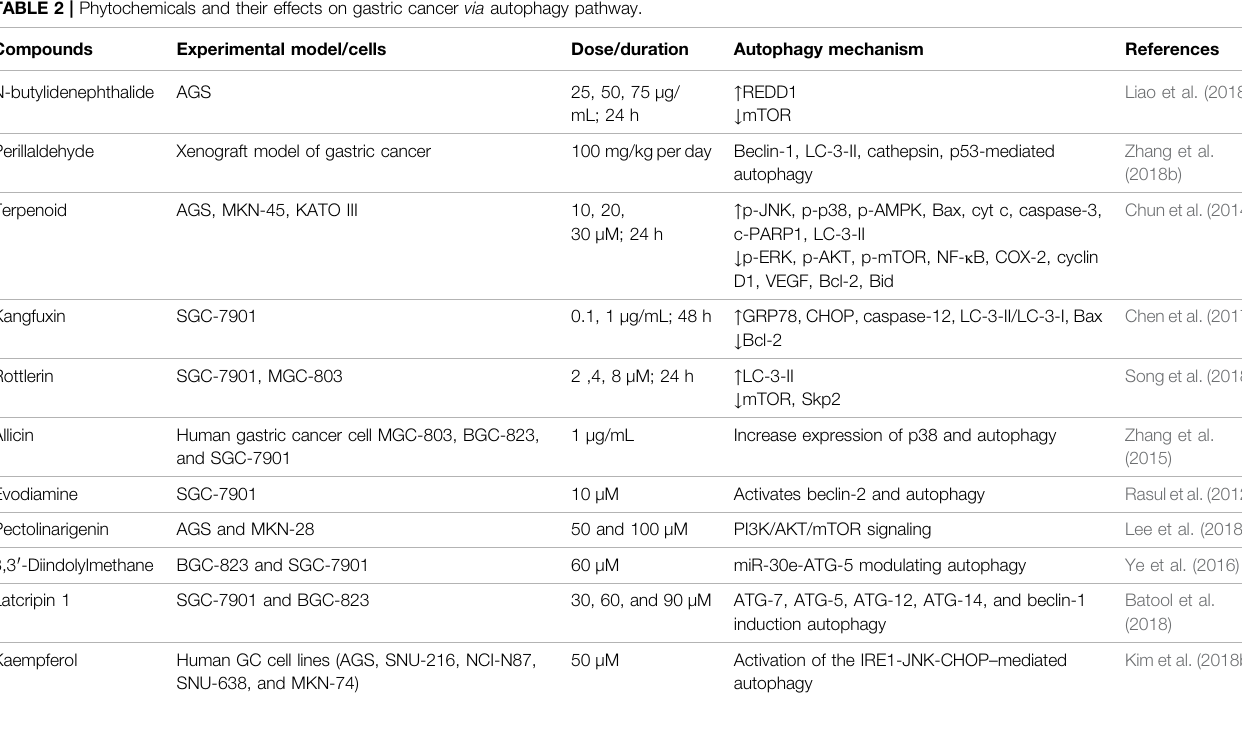
TABLE 2 | Phytochemicals and their effects on gastric cancer via autophagy